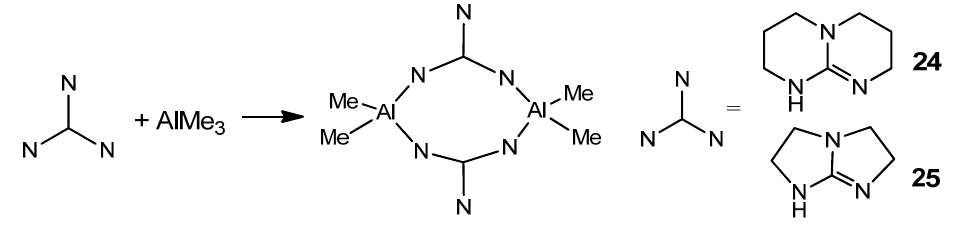
Figure 17. Bicyclic guanidinates acting as bridging ligands.